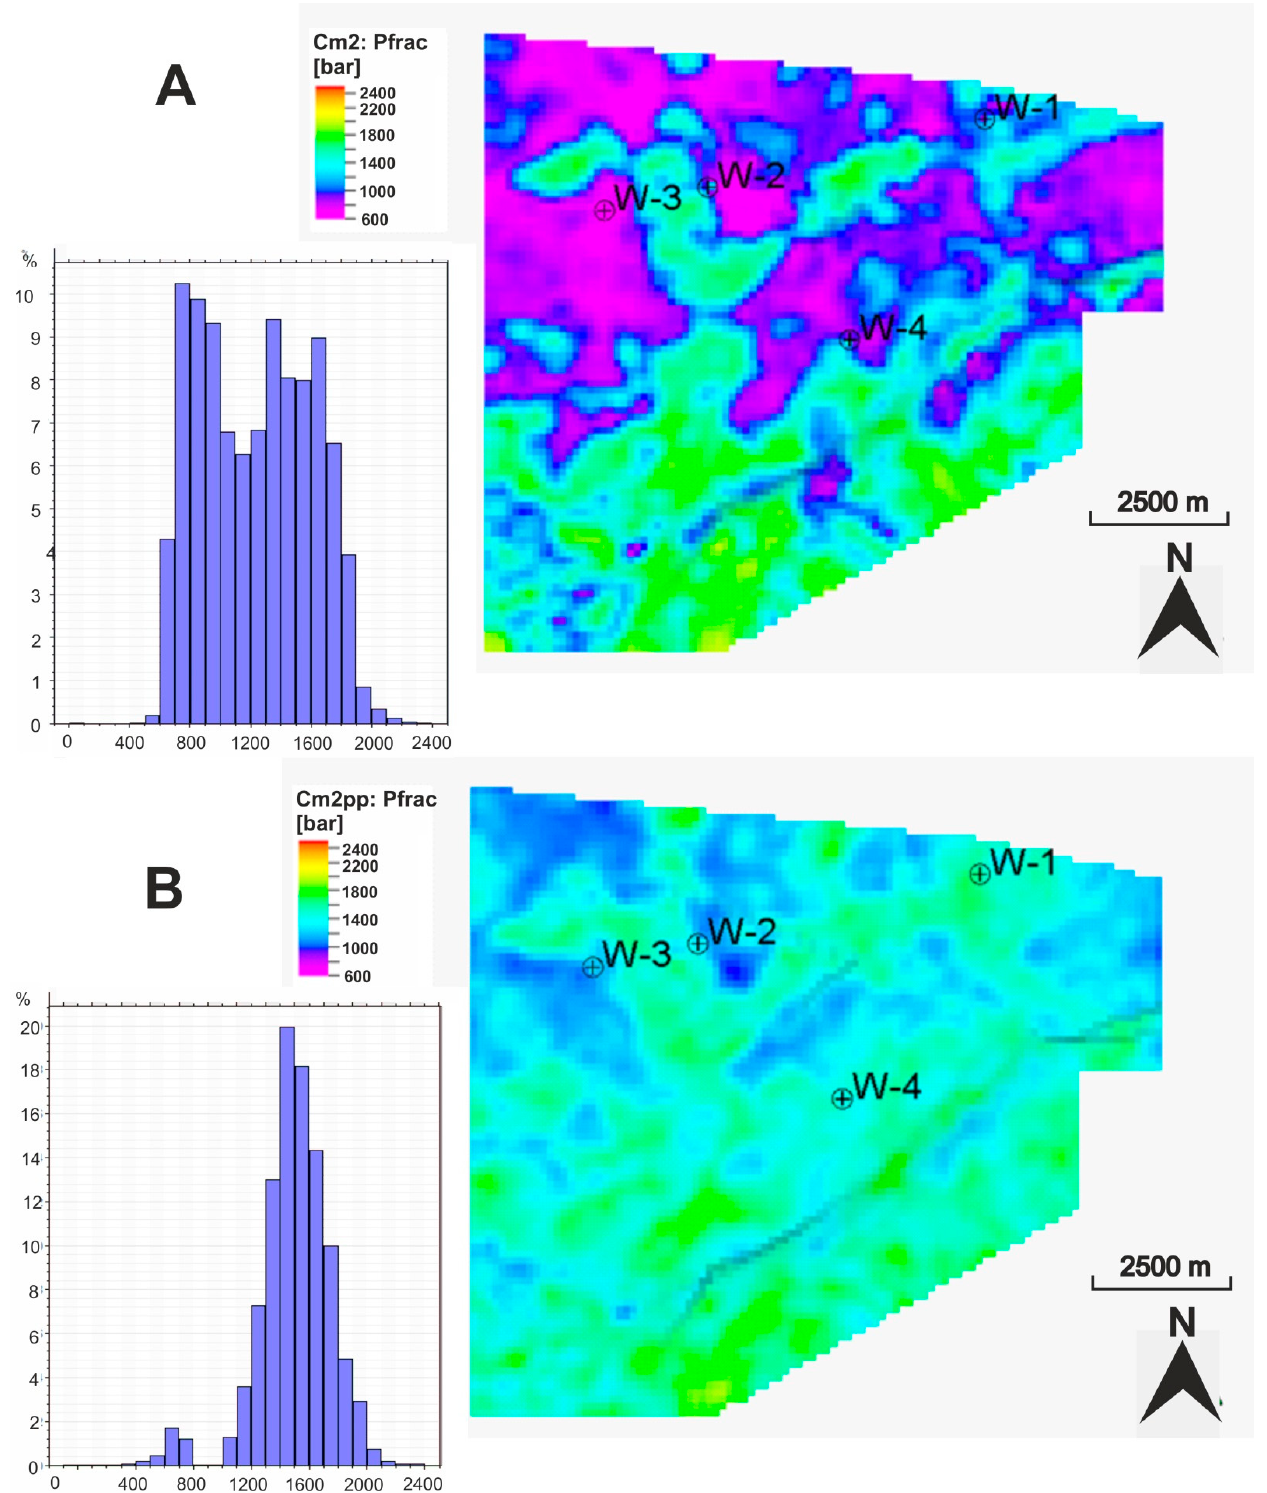
Figure 12. Average fracturing pressure in the Middle Cambrian formation Cm2 ( A ) and Paradoxides Paradoxissimus sandstones formation within in the Middle Cambrian CM2 interval ( B ).